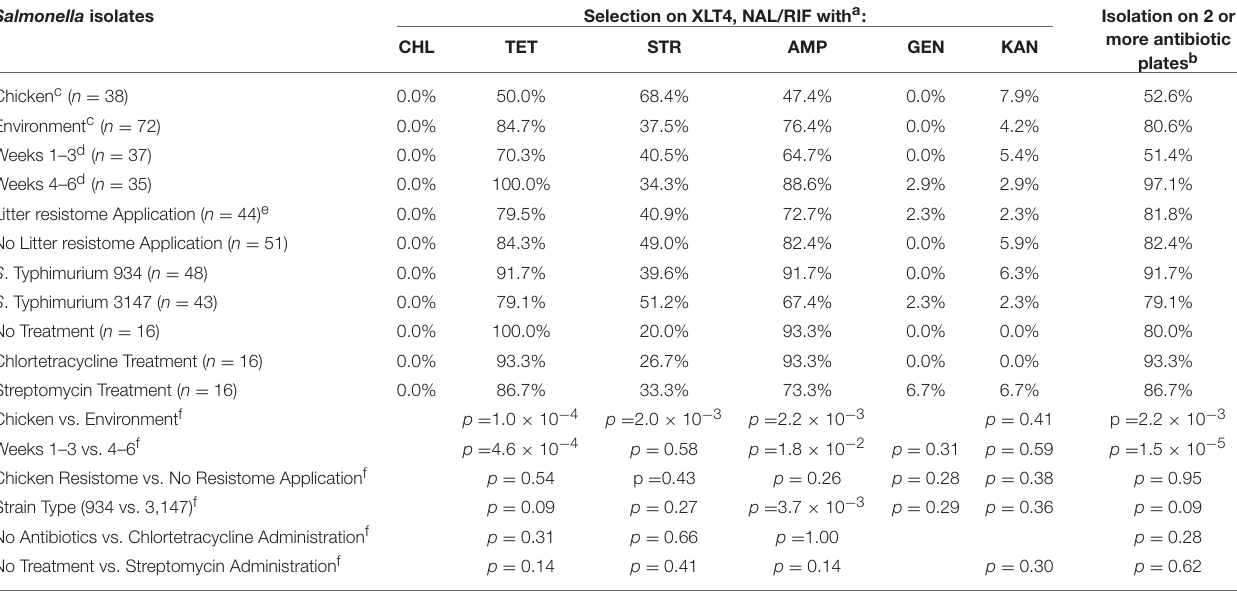
TABLE 9 | Antimicrobial resistance in Salmonella isolated from chickens administered antibiotics and chicken resistome. Salmonella isolates Selection on XLT4, NAL/RIF with a